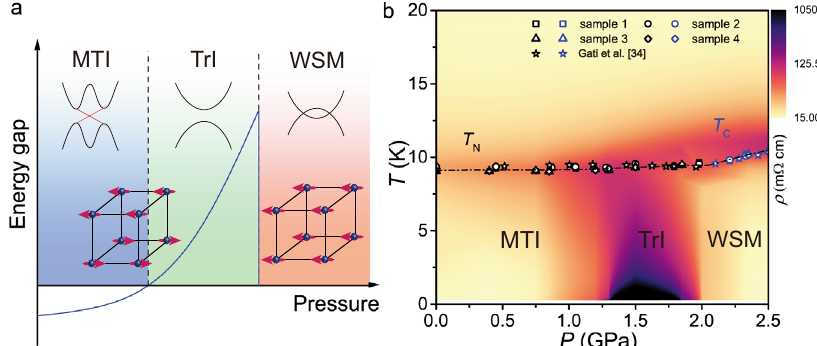
Fig. 5 Phase diagram of EuCd 2 As 2 under pressure. a Theoretically anticipated evolution of the ground state in EuCd 2 As 2 with increasing pressure, evolving from a magnetic topological insulator (MTI) to a trivial insulator (TrI), and then to a Weyl semimetal (WSM). Magnetic ground states and electronic structures associated with the MTI, TrI and WSM phases are shown schematically. The solid curve represents the evolution of the electronic gap, which is negative in the presence of a band inversion, and positive in its absence. b Color-coded experimental ρ ( T ) as a function of pressure and temperature for sample #4 (the results for other samples are provided in the Supplementary Fig. 7), note that ρ / dT , respectively corresponding to transition ρ ( T ) is shown on a log scale. T N (black symbols) and T C (blue symbols) mark local maxima in d temperatures into the AFM and FM phases (see Supplementary Fig. 8). For comparison, the magnetic transition temperatures from Ref. 34 are also included in the plot.